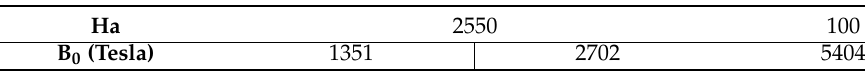
Figure 1. Configuration of the physical model. Table 1. Magnetic flux-density range.